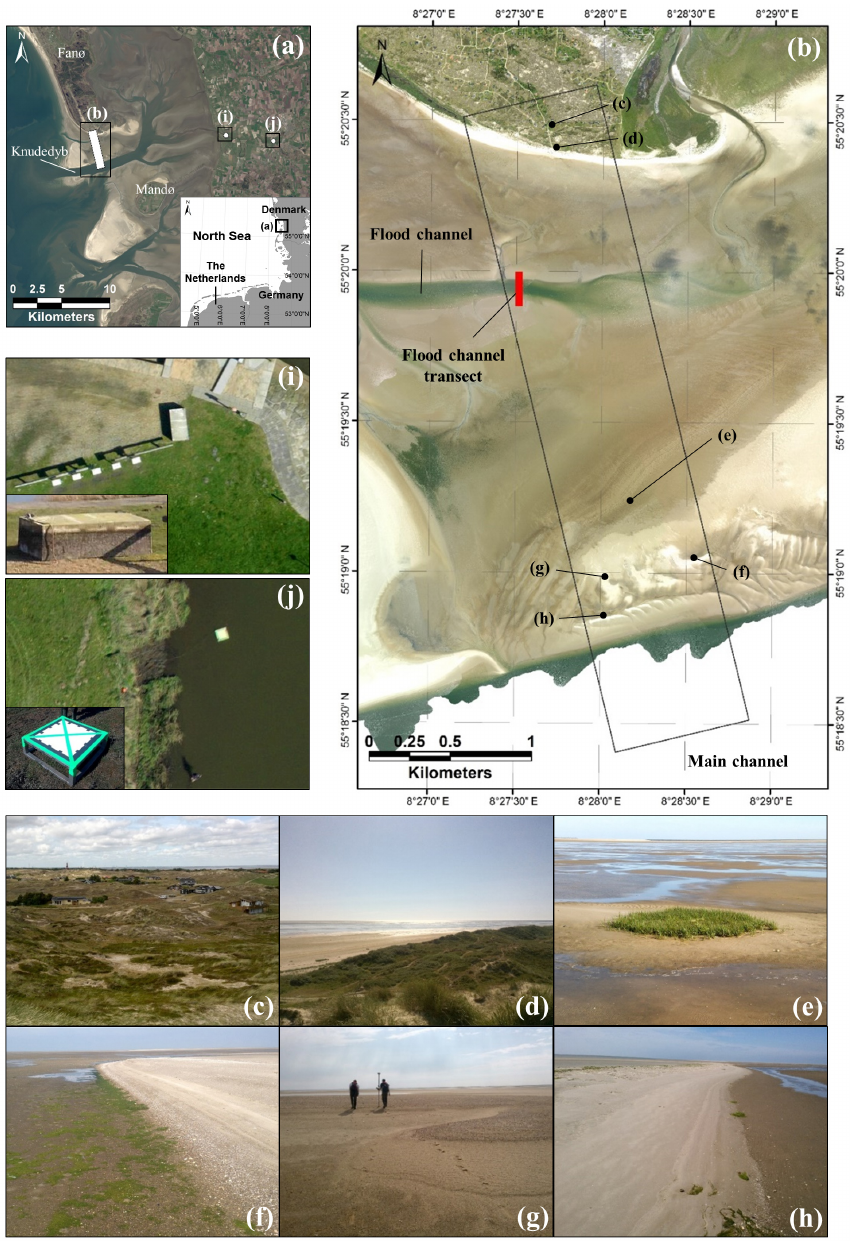
Figure 1. (a) Overview of the study area location in the Danish Wadden Sea (22 April 2014 satellite image, Landsat 8). (b) The study site in the Knudedyb tidal inlet system (30 May 2014 Orthophoto, AHM). Panel (c) shows cottages in the dunes on Fanø; (d) beach dunes on Fanø; (e) patch of Spartina townsendii (common cord grass); (f) – (g) swash bars; (h) linear bar; (i) validation site 1 with a cement block on land, used for accuracy and precision assessment (19 April 2014 orthophoto, AHM); (j) validation site 2 with a steel frame in Ribe Vesterå River, used for precision assessment (19 April 2014 orthophoto,